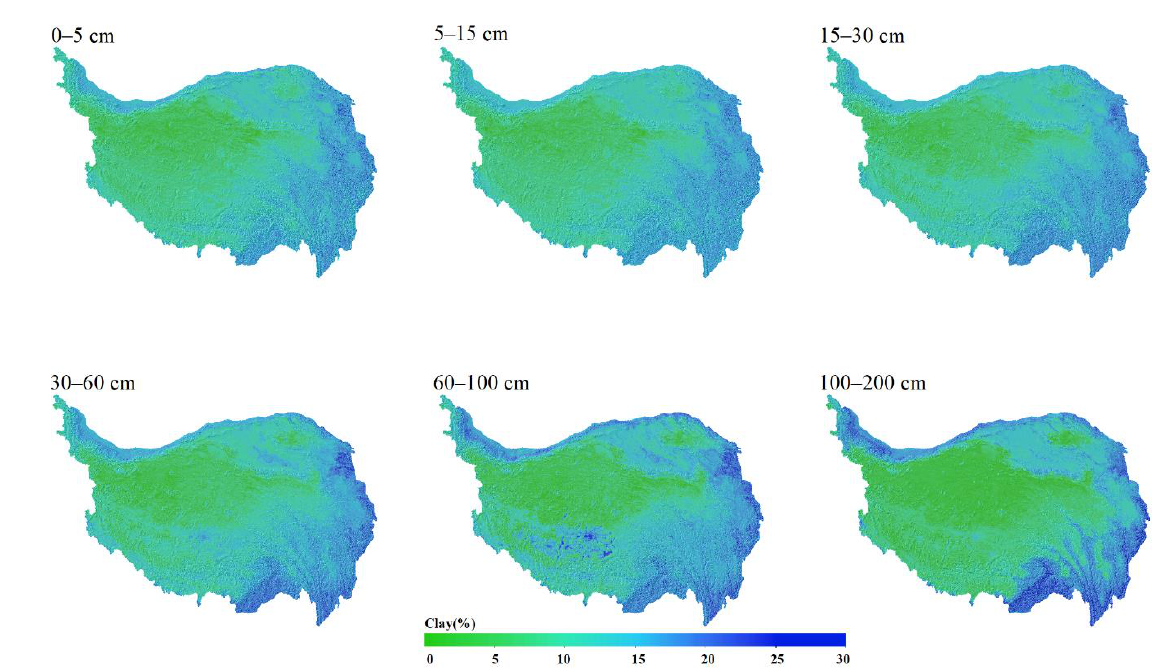
Figure 2. Spatial distribution of clay content at the six depth intervals.